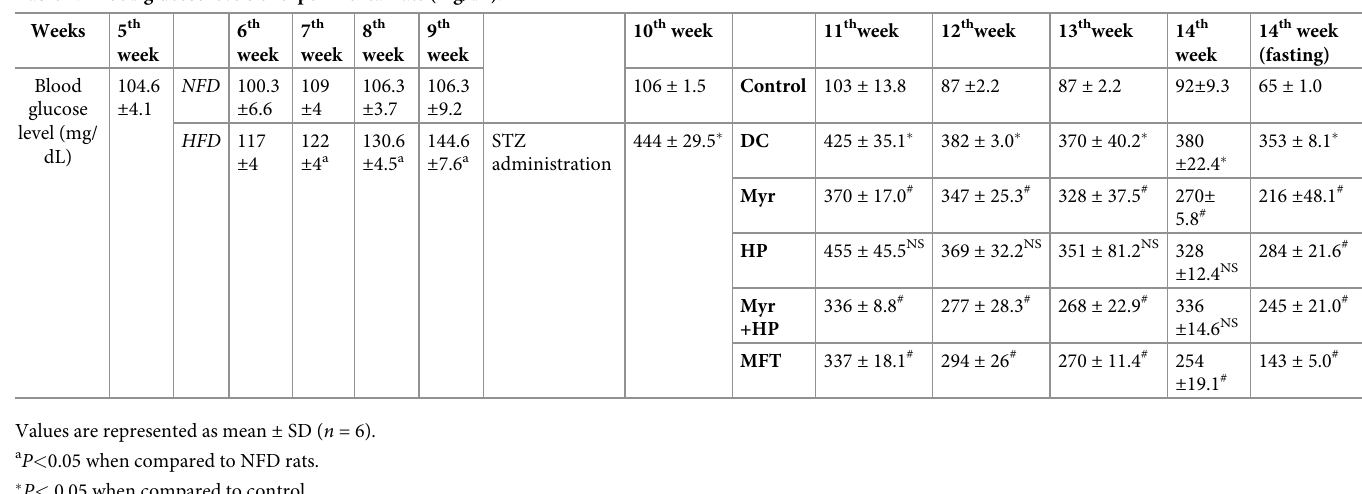
Table 2. Blood glucose levels of experimental rats (mg/dL).